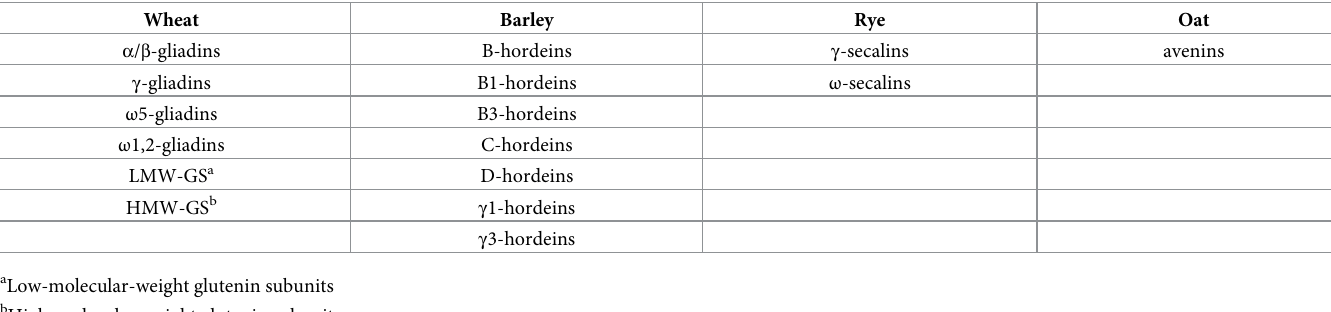
Table 1. Prolamins and glutelins from gluten-containing grains. Wheat